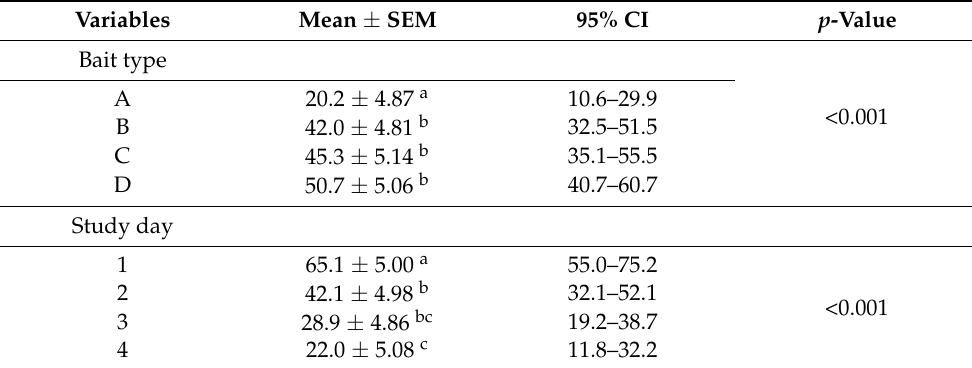
Table 4. Mean ± SEM (Standard Error of Mean) of number of chews between the different bait types and study days in dogs.